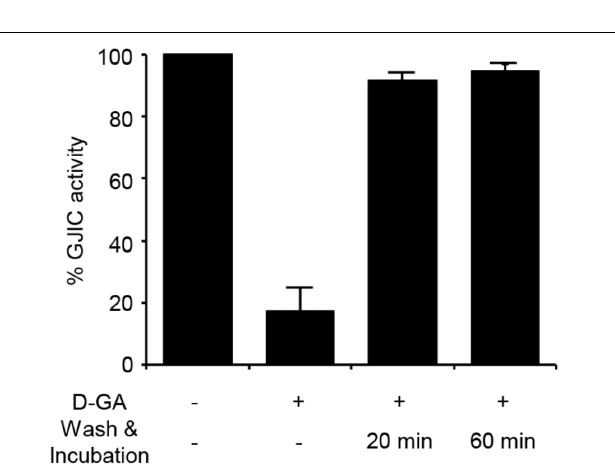
FIGURE 4 | Reversible inhibition of GJIC by D-GA. The 2:1 mixture of LN215-I and LN215-YFP cells were plated on four separate 96-well plates. After incubation for 24 h, the cells were treated as indicated above. D-GA was treated at 20 µ M for 10 min. For the wash and incubation groups, the cells were washed with growth media twice and further incubated for 20 or 60 min before the I-YFP GJIC assay was performed. The control group (without D-GA treatment) was used to calculate the percentage of GJIC activity, which was presented as the mean ± SD of three independent experiments in a bar